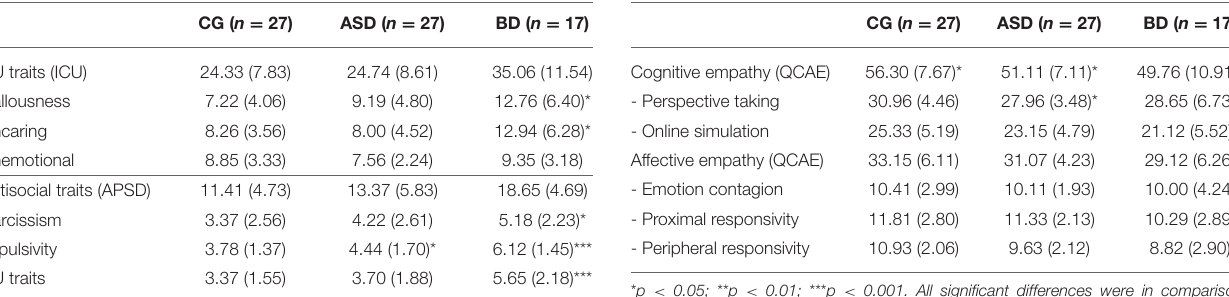
TABLE 2 | Means (standard deviations) on CU and antisocial traits, and their subscales.